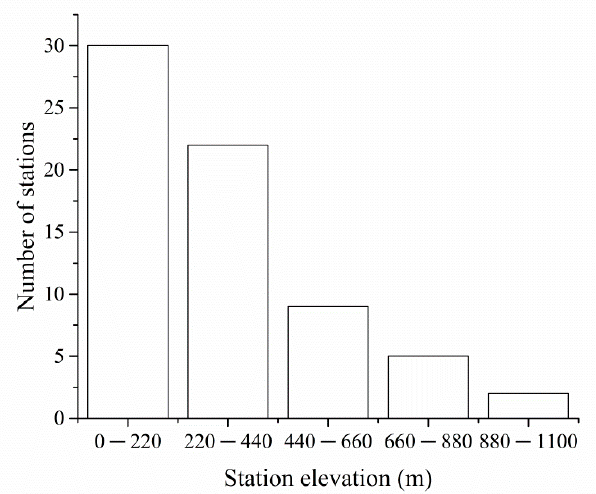
Figure 2. The numberof meteorological stations at different elevations.